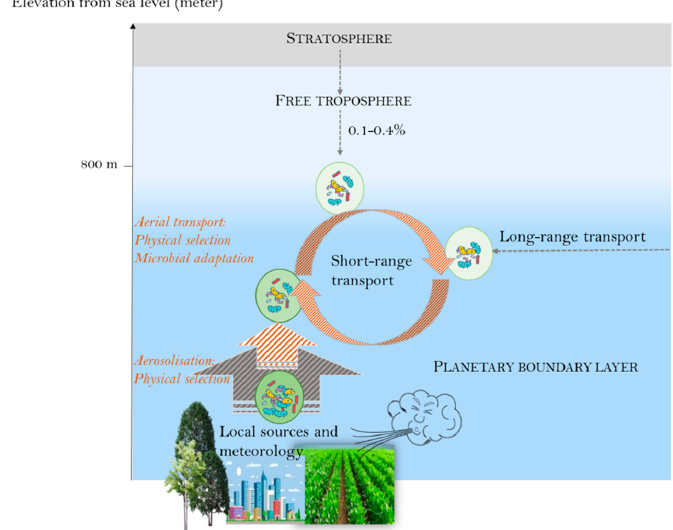
Figure 3. Overview of the role of di ff erent factors in controlling microbial communities of the planetary boundary